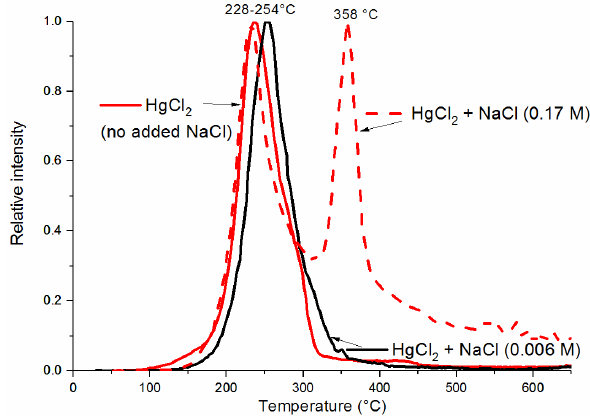
in a saturated solution 2